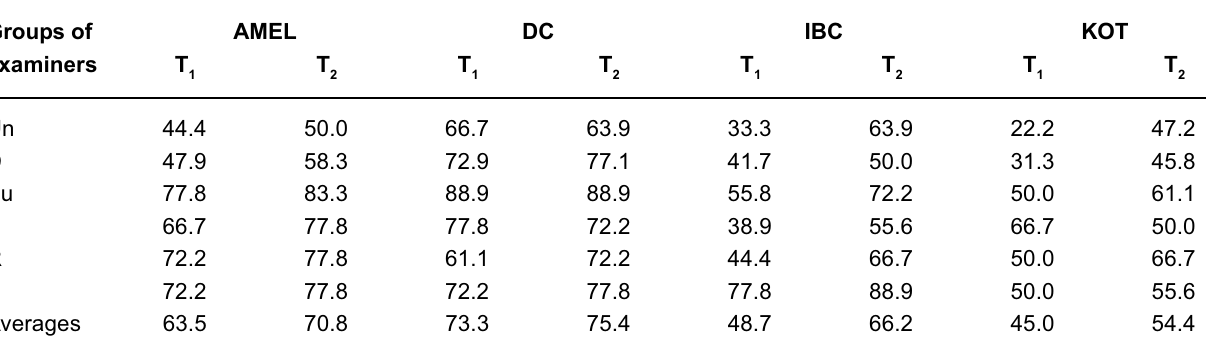
TABLE 2- Rates (%) of correct answers before (T examiners, according to type of lesion